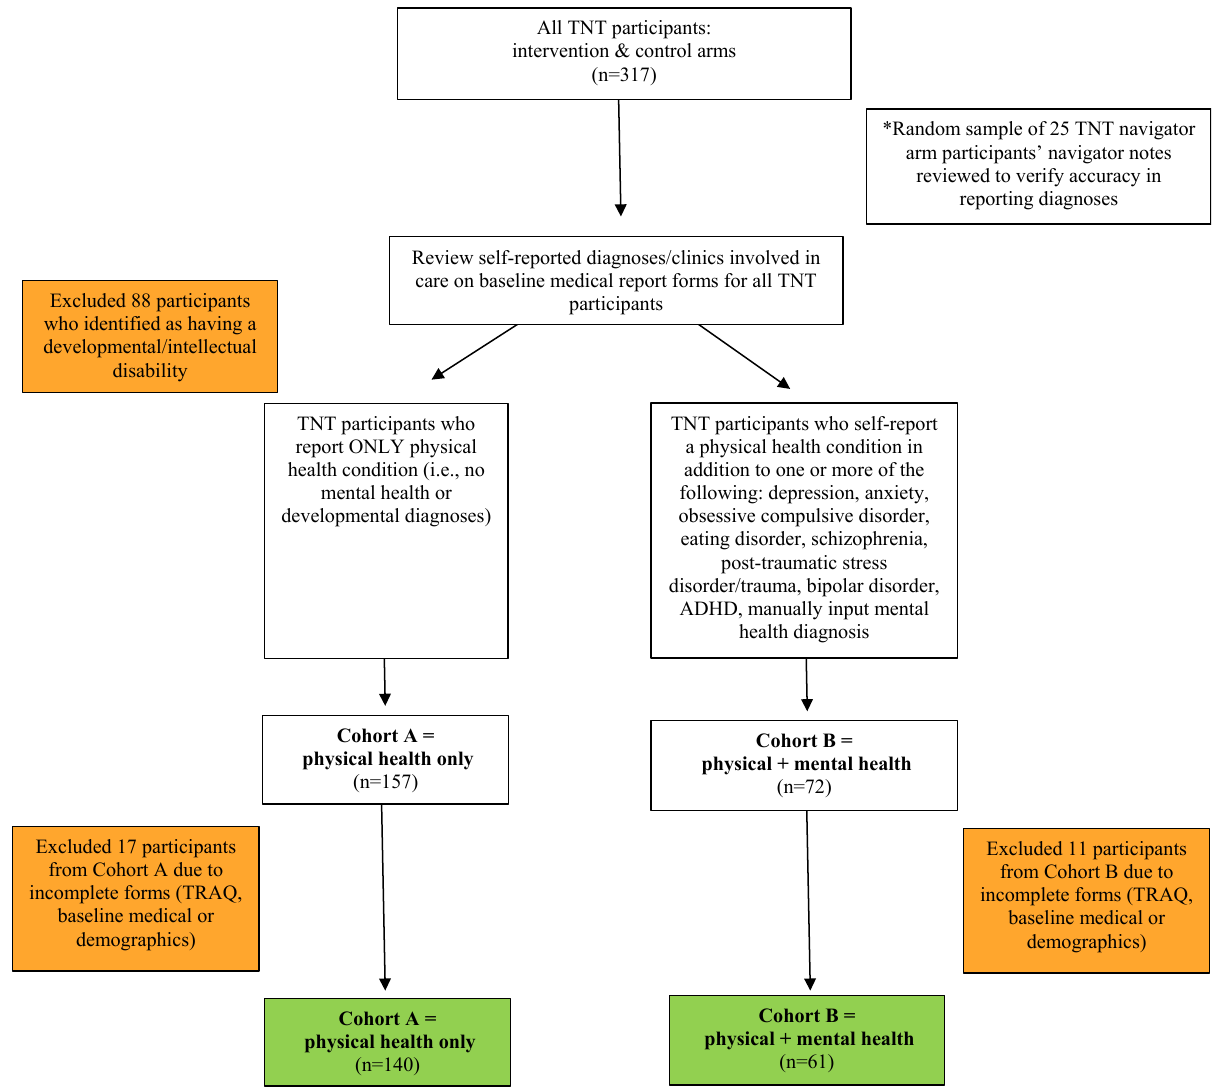
Figure 2: Phase 1 READY2Exit participants. TNT, transition navigator